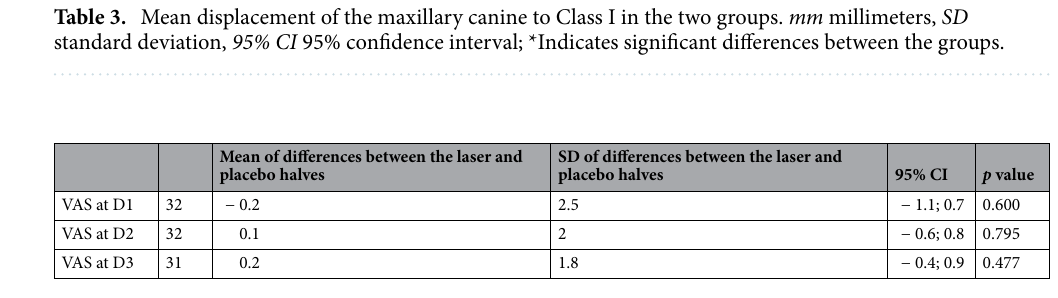
SD of differences between the laser and placebo halves 95% CI